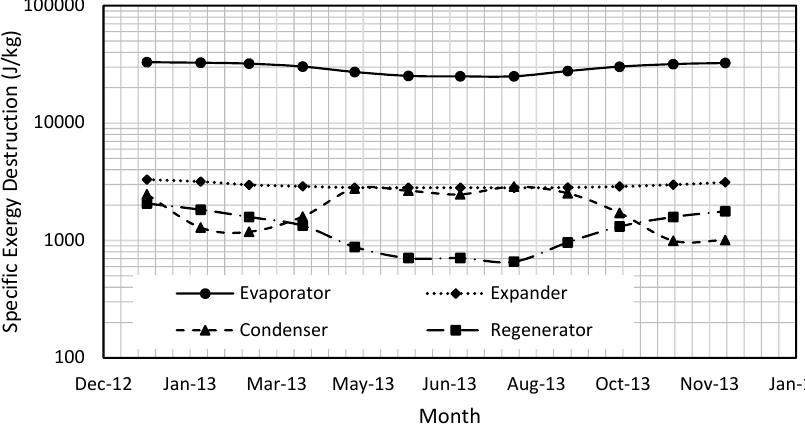
Figure 15. Superheat at expander inlet over the course of the year for a heat source temperature of 75 °C under Beijing’s ambient conditions.